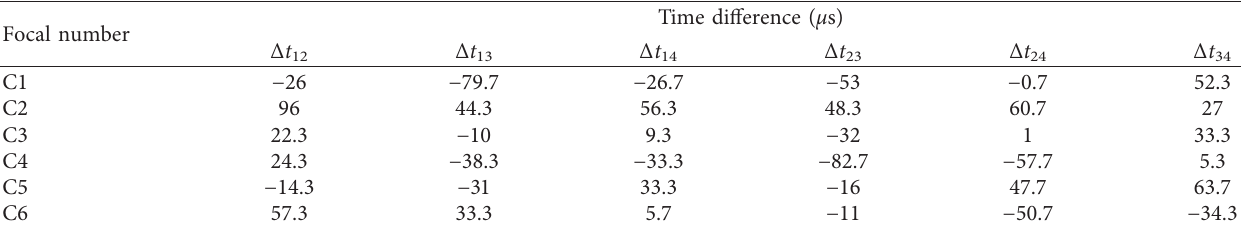
Table 19: The comparison of positioning results of cross-correlation technique based on wavelet packet decomposition and experiments. Focal number